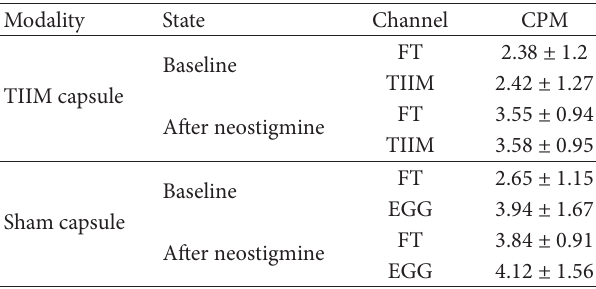
Table 2: Averaged cycles per minute (CPM) of the raw force transducer (FT) and the cutaneous recordings per state per capsule